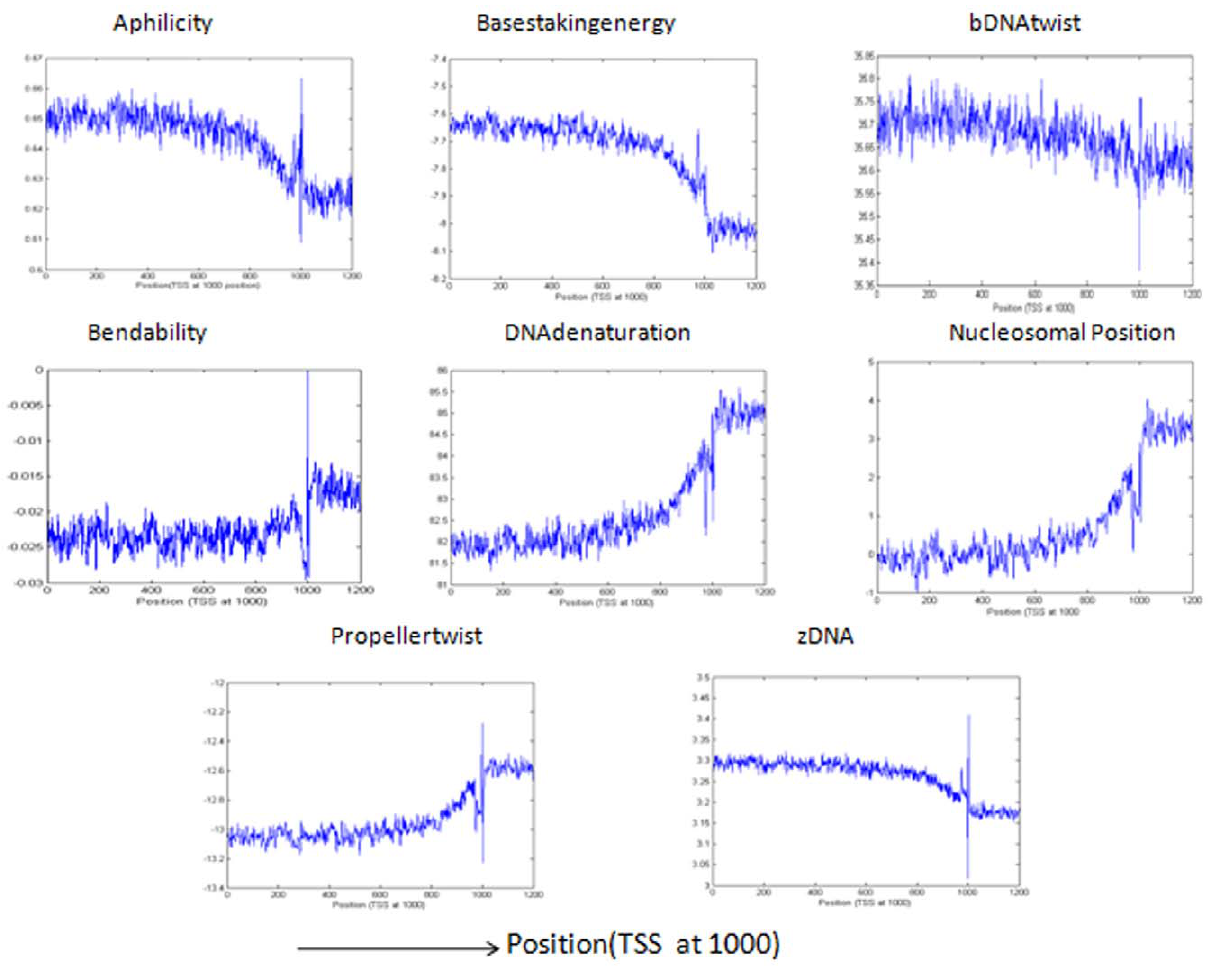
Figure 3. Structural pattern of eight different features for the sequences taken from UCSC table browser of hg19 human genome. The sequences used here are not generated by grammars i.e. redicted as nonpromoter. The structural profiles are plotted with average value of window size 3 nt.